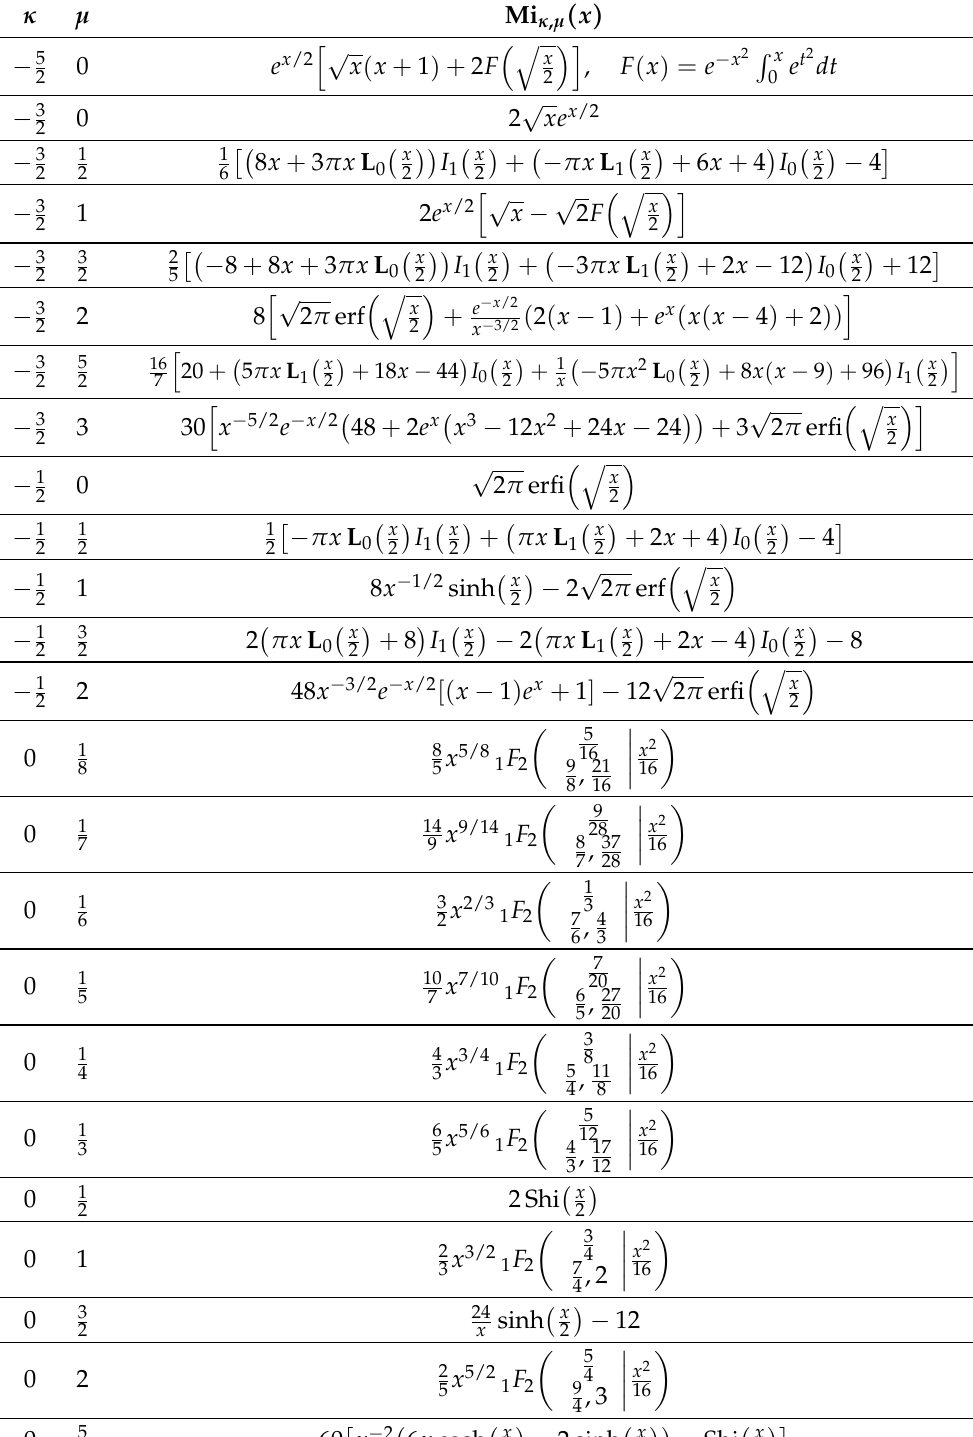
Table 5. The integral Whittaker functions Mi κ , µ derived for some values of parameters κ and µ by using (18) and